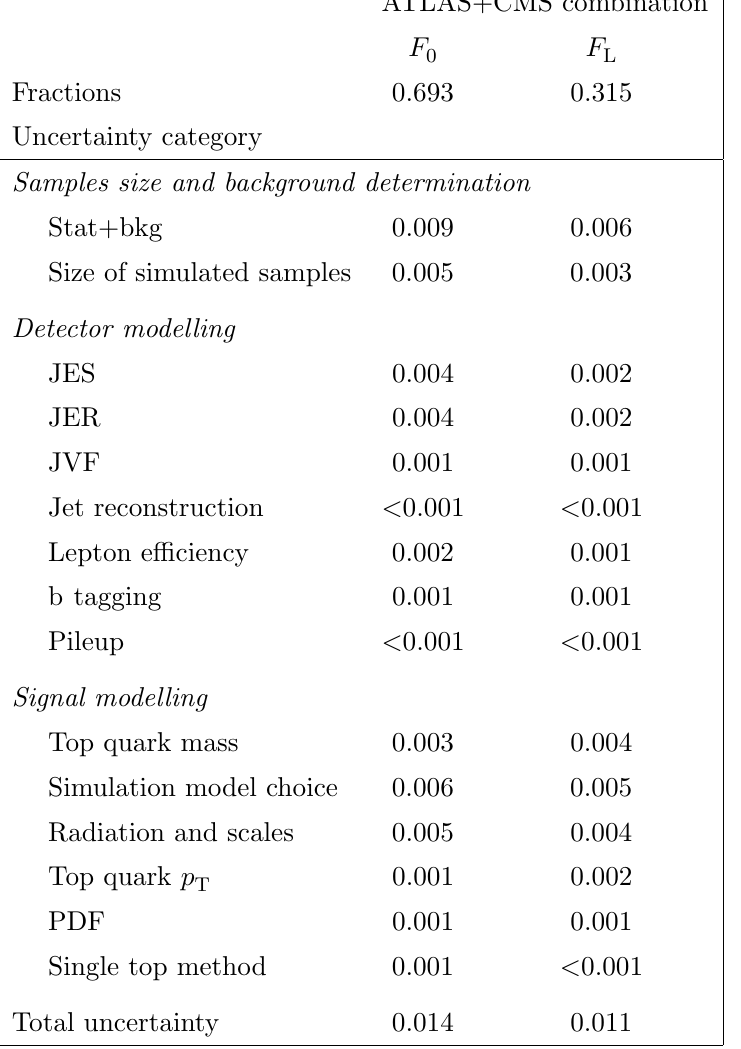
, (cid:26) e+jets , (cid:26) m +jets ATLAS CMS CMS